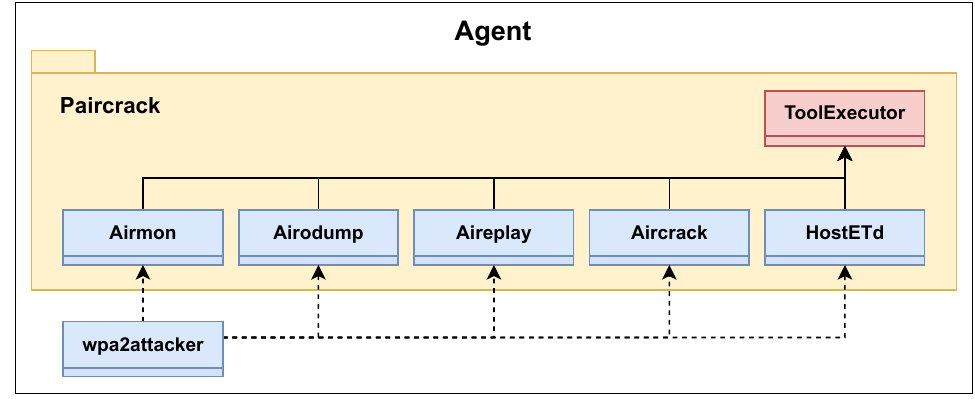
Figure 21. Class diagram of the